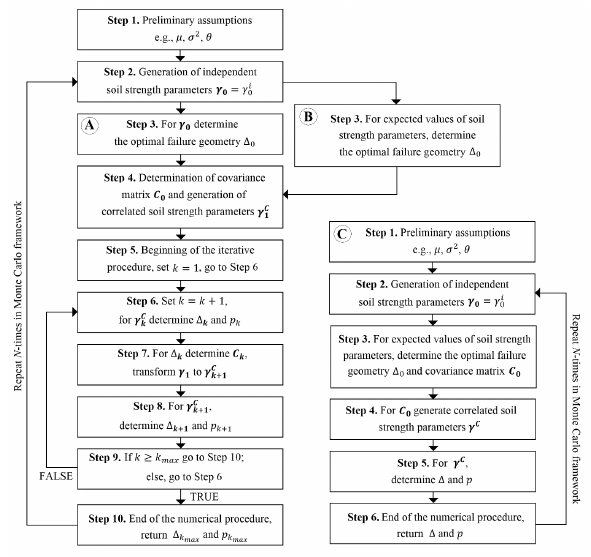
Figure 1: The three algorithms discussed in the study. Path ‘A’ is the base iterative algorithm, which is described in detail in the text, the path ‘B’ differs only from ‘A’ in Step 3 (see the description in the text), and the path ‘C’ is dedicated to a constant covariance matrix. Both ‘A’, ‘B’, and ‘C’ are repeated N times in the Monte Carlo